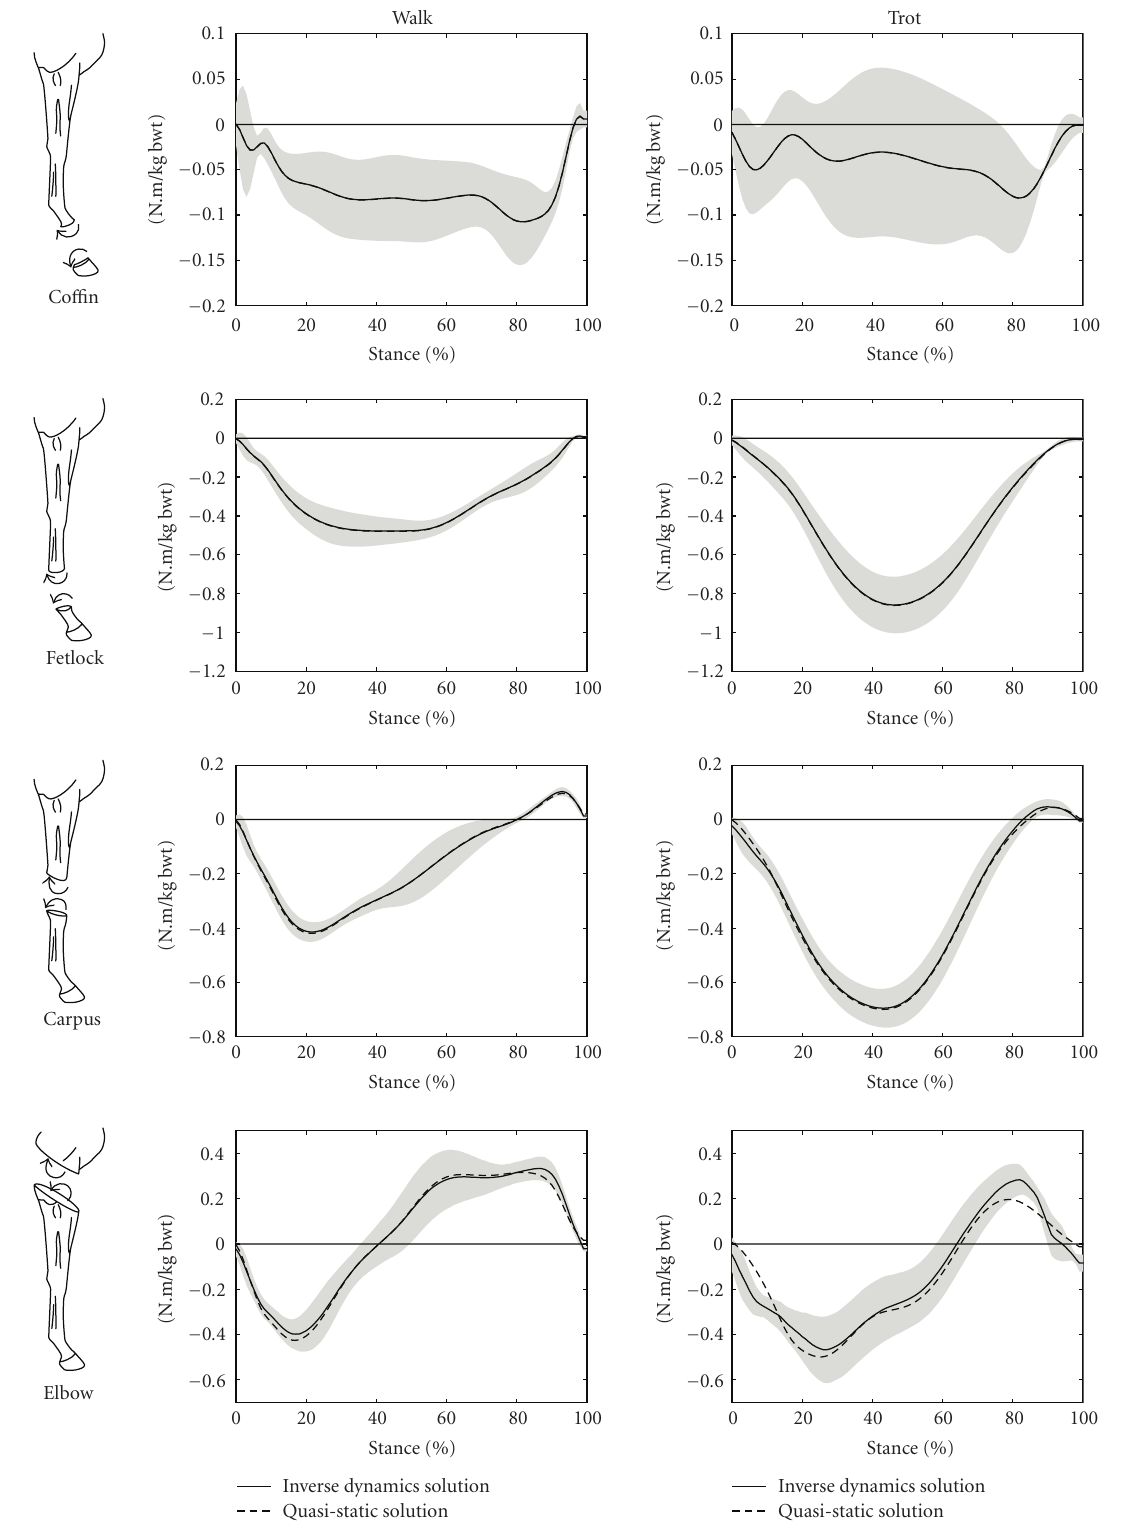
Figure 4: Joint moments calculated at the co ffi n, fetlock, carpus, and elbow joints for walking and trotting during the stance phase of the stride. The mean values of the inverse dynamics solutions are shown as solid lines with grey shading representing ± 1 SD, while the mean values of the massless, quasi-static analysis are shown as dashed lines. The stance phase of the stride was the time during which the vertical component of the ground reaction force was greater than 50N. 0% of stride was the time of first hoof-ground contact, while 100% of stride was the time of last hoof-ground